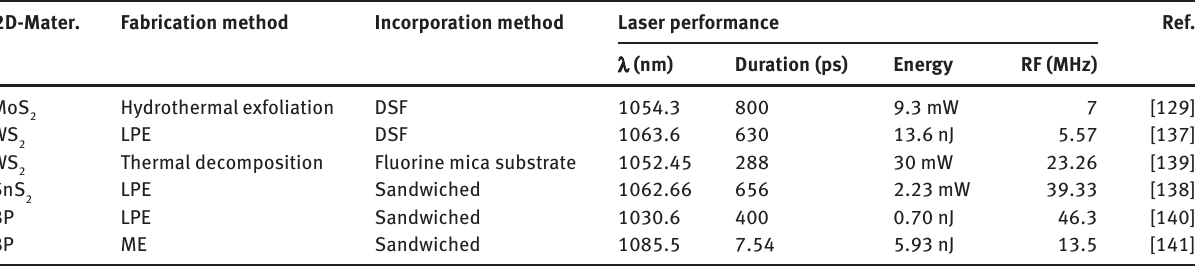
Table 2: Summarization of mode-locked fiber laser at 1.06 μ m based transition-metal dichalcogenides (TMDCs) and black phosphorus (BP) saturable absorbers